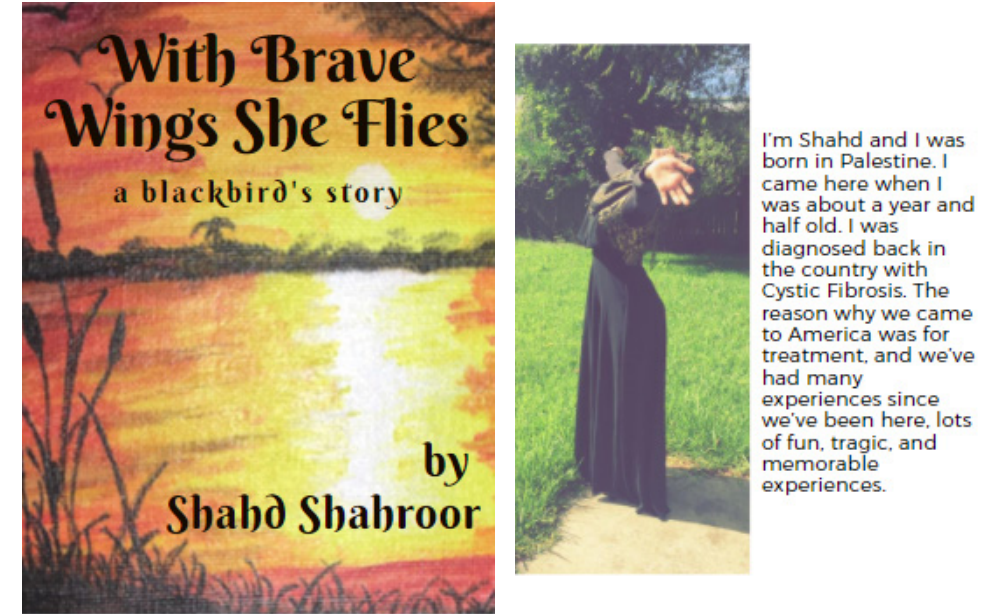
Figure 1. Printed with permission from Shahd Shahroor. Original art and photograph.